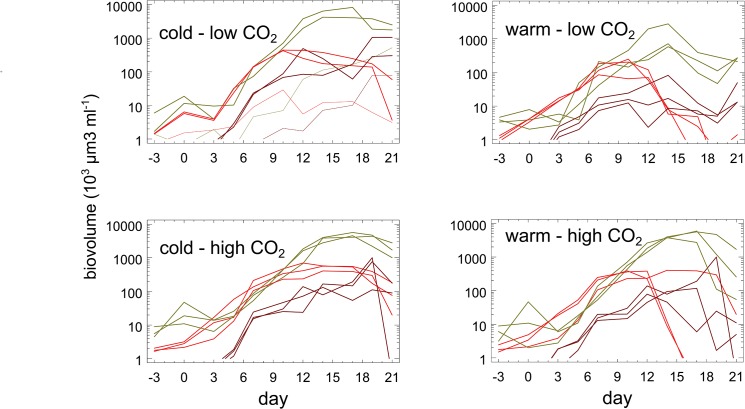
Time course of the biovolumes of dominant higher taxa.Diatoms (olive), cryptophytes (red), and prymnesiophytes (brown), the trajectories from the aberrant mesocosm 9 are shown by dotted lines.